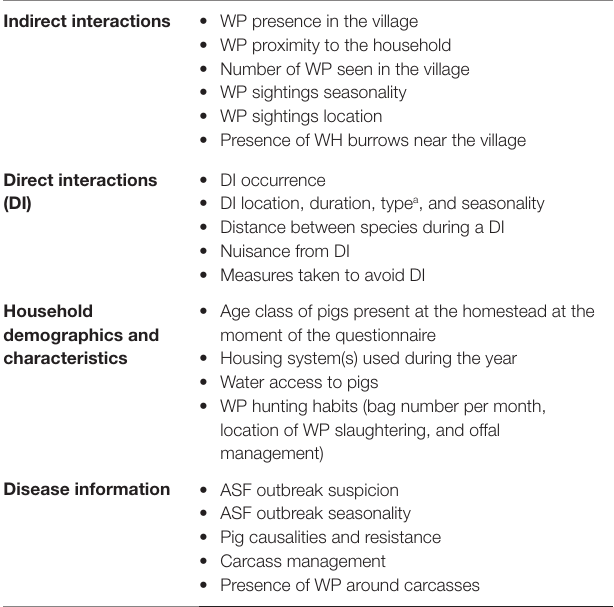
TaBle 1 | Main variables collected during individual interviews implemented in household-owning pigs at nwoya district, Uganda, in